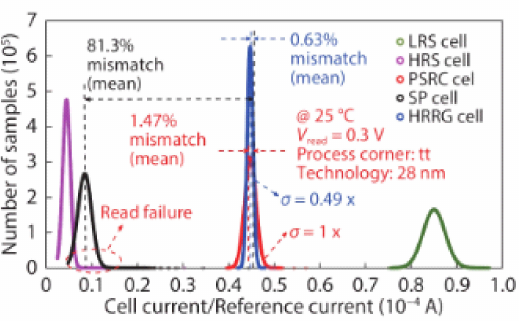
Figure 4. The distributions of cell current and the reference current [77].